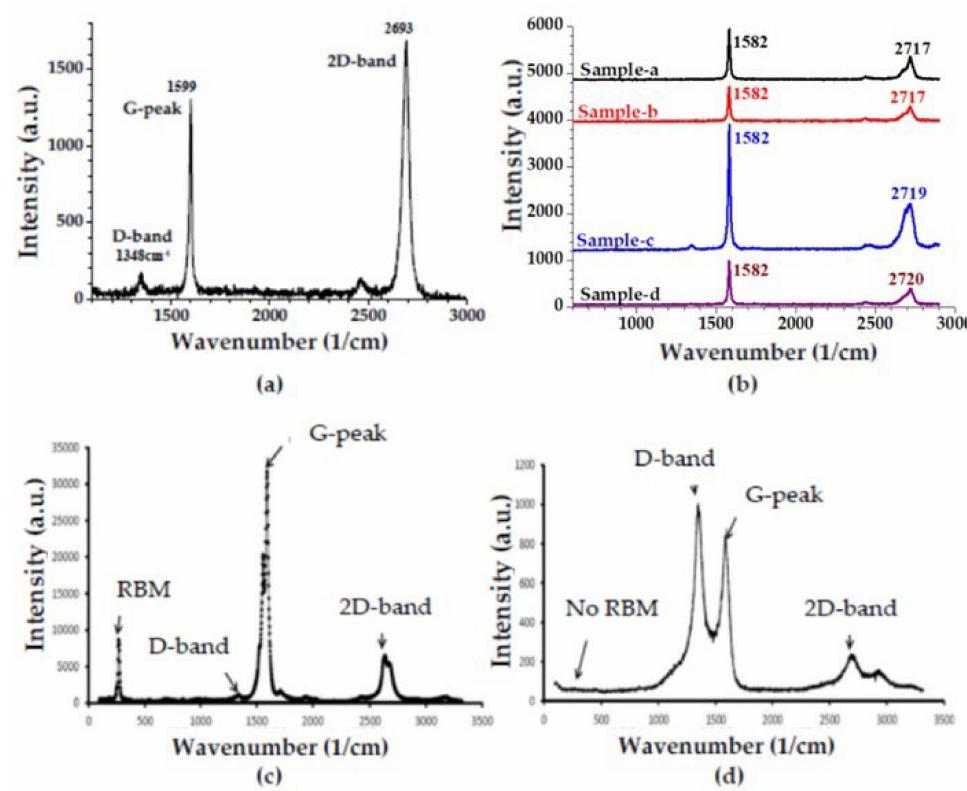
Figure 9. Raman spectrum of ( a ) single-layer graphene, ( b ) many-layer graphene, ( c ) SWCNTs and ( d ) MWCNTs. Subfigures ( c , d ) have been adapted from [123] with permission from Springer Nature. Subfigure ( b ) has been adapted from [118] with permission from MDPI. (Raman